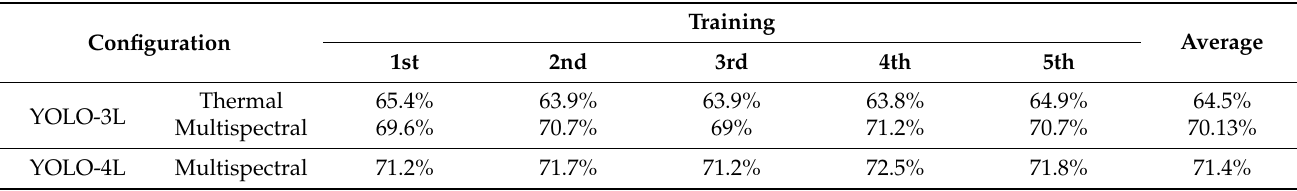
Table 3. Unified model comparison among thermal-based (YOLO–3L) and multispectral-based (YOLO–3L and YOLO–4L).